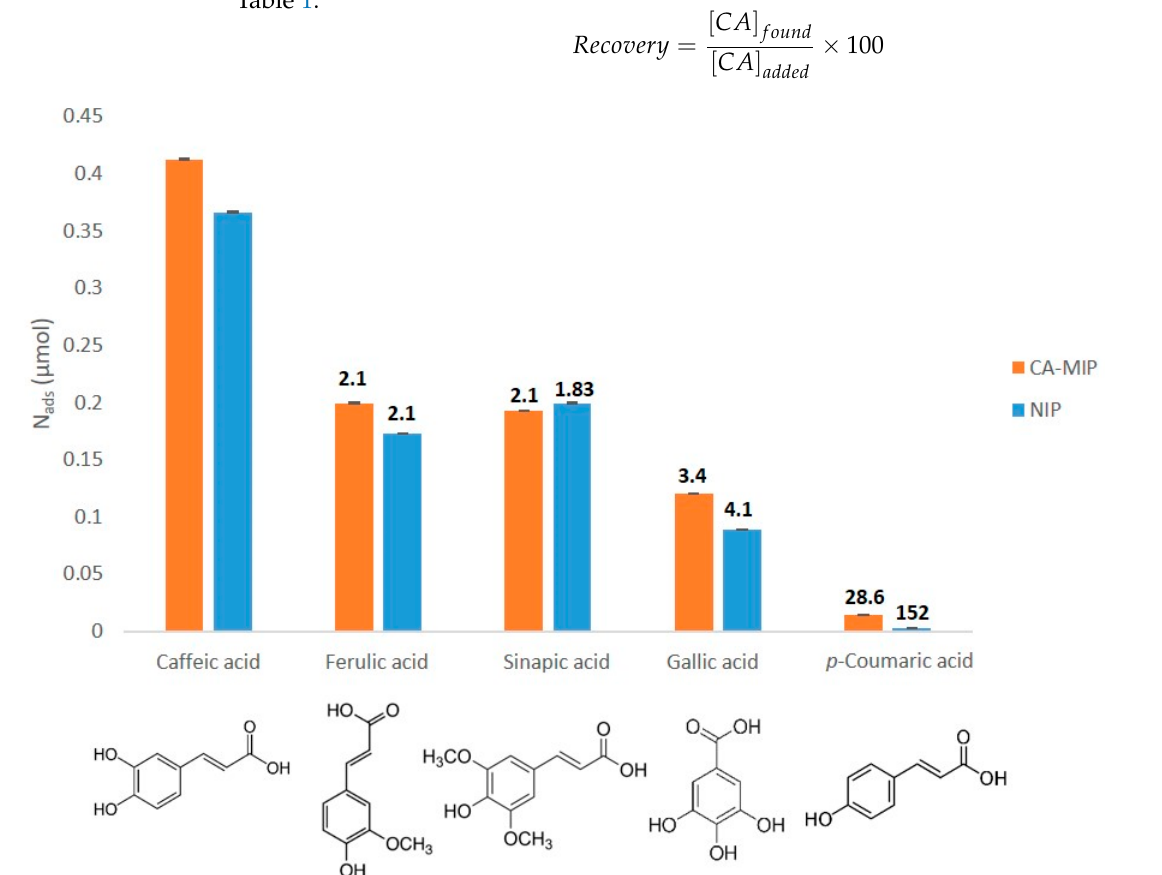
Figure 5. Relative amount of caffeic acid and its interferents adsorbed by the CA-MIP and NIP in a PBS 0.05M/EtOH (90/10, v / v ) solution containing 0.55 mM of each compound, in the presence of 10 mg of MIP or NIP. The selectivity coefficient α is represented in bold above every bar. Interferents: ferulic acid, sinapic acid, gallic acid, and p -coumaric acid.